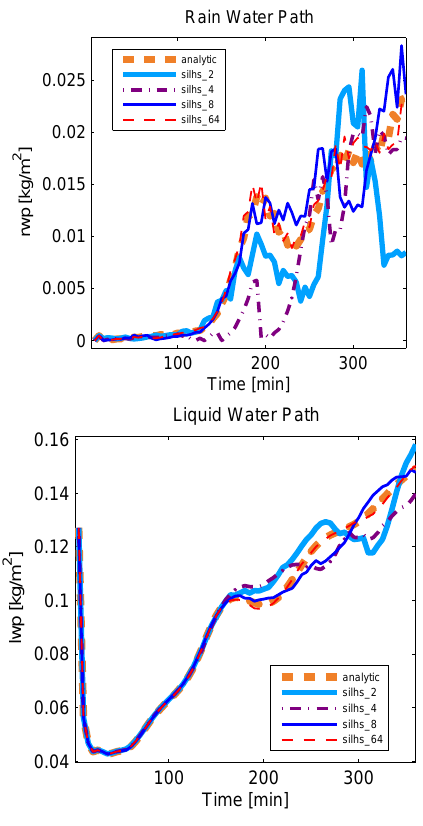
Fig. 1. Time series of rain water path (upper) and liquid water path (lower) from the RICO shallow cumulus case. Five different integrations of the microphysics are overplotted: analytic (orange dashed), and SILHS-based sampling with 2 points (light blue solid), 4 points (purple dot dashed), 8 points (dark blue solid), and 64 points (red dashed) per grid box and time step.